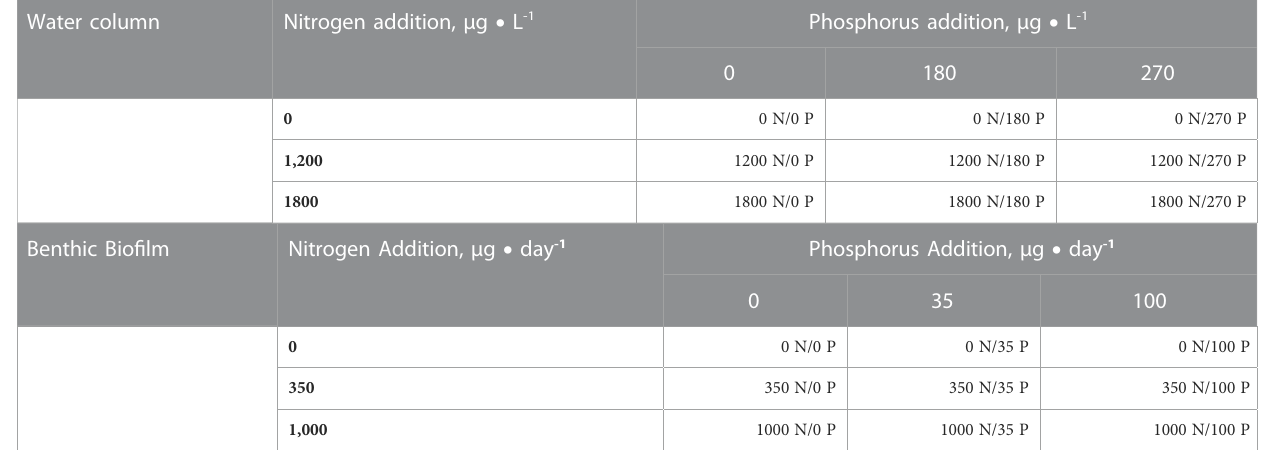
TABLE 1 Schematic outlining the 3 × 3 factorial design used for experiments performed in the Chippewa River watershed, Michigan (October 2013). For the water column experiments, nutrients were added at three levels for both N and P (as a single spike in μ g L -1 ) to triplicate water samples. For benthic bio fi lms, nutrients were added at three levels of loading (over time as μ g day -1 ) for both N and P to triplicate in situ nutrient releasing substrata. Water